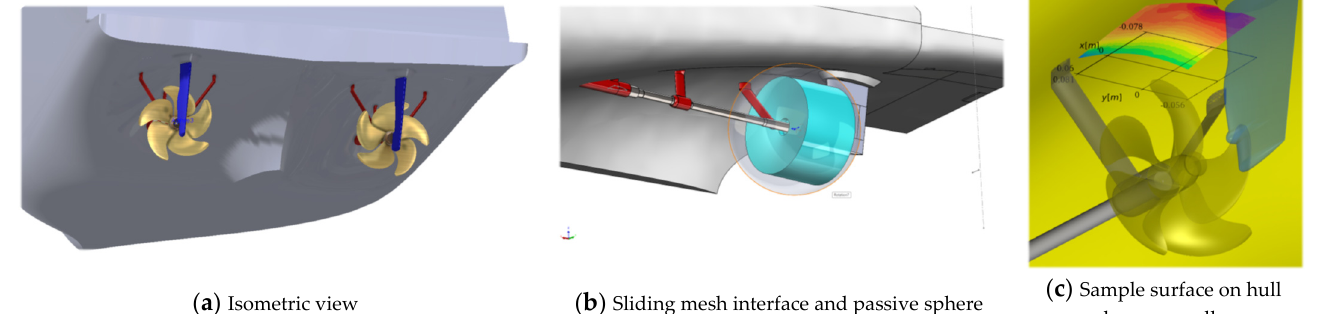
Figure 1. Test case 3D-model.